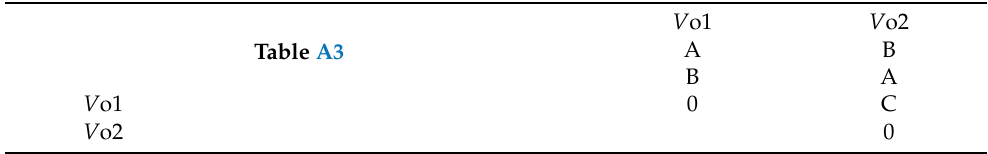
Table A7. Configurational Matrix (mutual interatomic distances in NN, as in Table A2) for x = 0.125, δ = 0.125. Five configurations (A,B,C), as in Table A10.